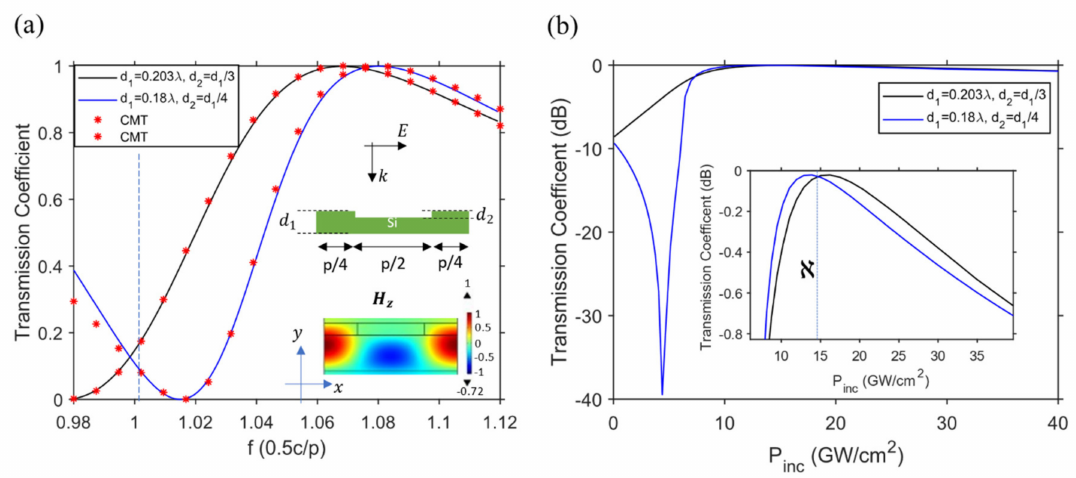
Figure 4. Full wave simulation results for the design of an optical Fano resonator for free-space radiation at normal incidence, achieved by choosing p = λ /2, where λ is the free-space wavelength. ( a ) Linear response of the transmission coefficient of individual resonators arranged in a periodic array, with period p excited with a normally incident plane wave, with polarization as shown in the inset. The red markers indicate the CMT results with the fitting parameters given in Table 3 in Section 5.5 (Fano Resonator Parameters). The color plot inset shows the z-component of the magnetic field distribution inside the slab, consistent with the guided mode inside the unperturbed dielectric slab of the same thickness, and the color bar is normalized to the maximum field. ( b ) Transmission coefficient for individual resonators in dB versus the incident power for normal incidence assuming χ ( 3 ) = 2.8 × 10 − 18 m 2 / V 2 at the resonance